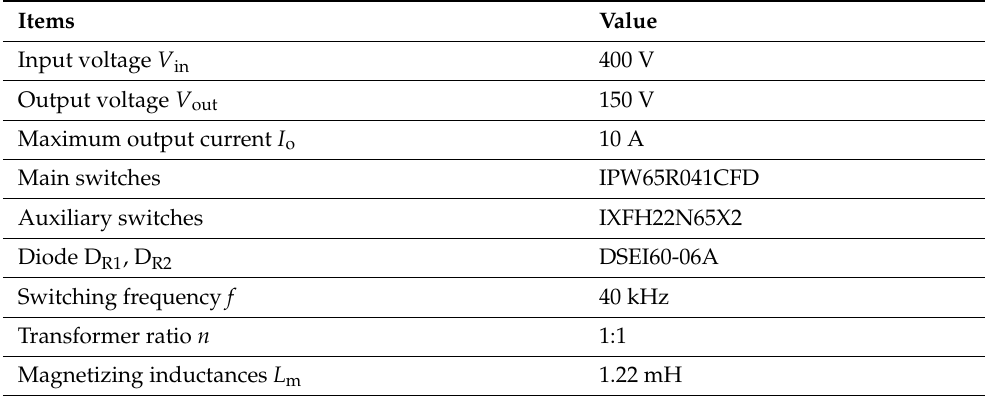
Table 1. The specifications of the prototype